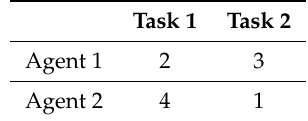
Table 1. Cost of Agents by